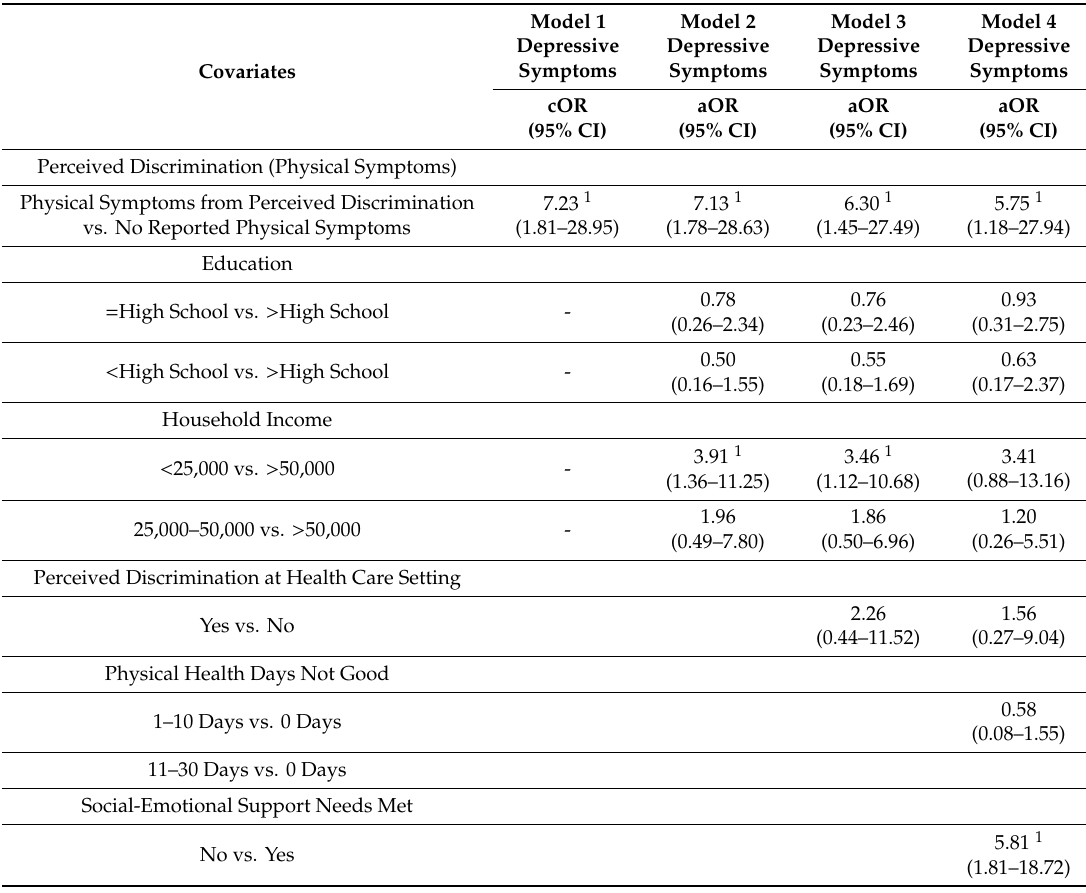
Table 3. Crude and adjusted associations between physical symptoms from perceived discrimination and self-reported depressive symptoms among African American (AA) men in the Southeastern United States,